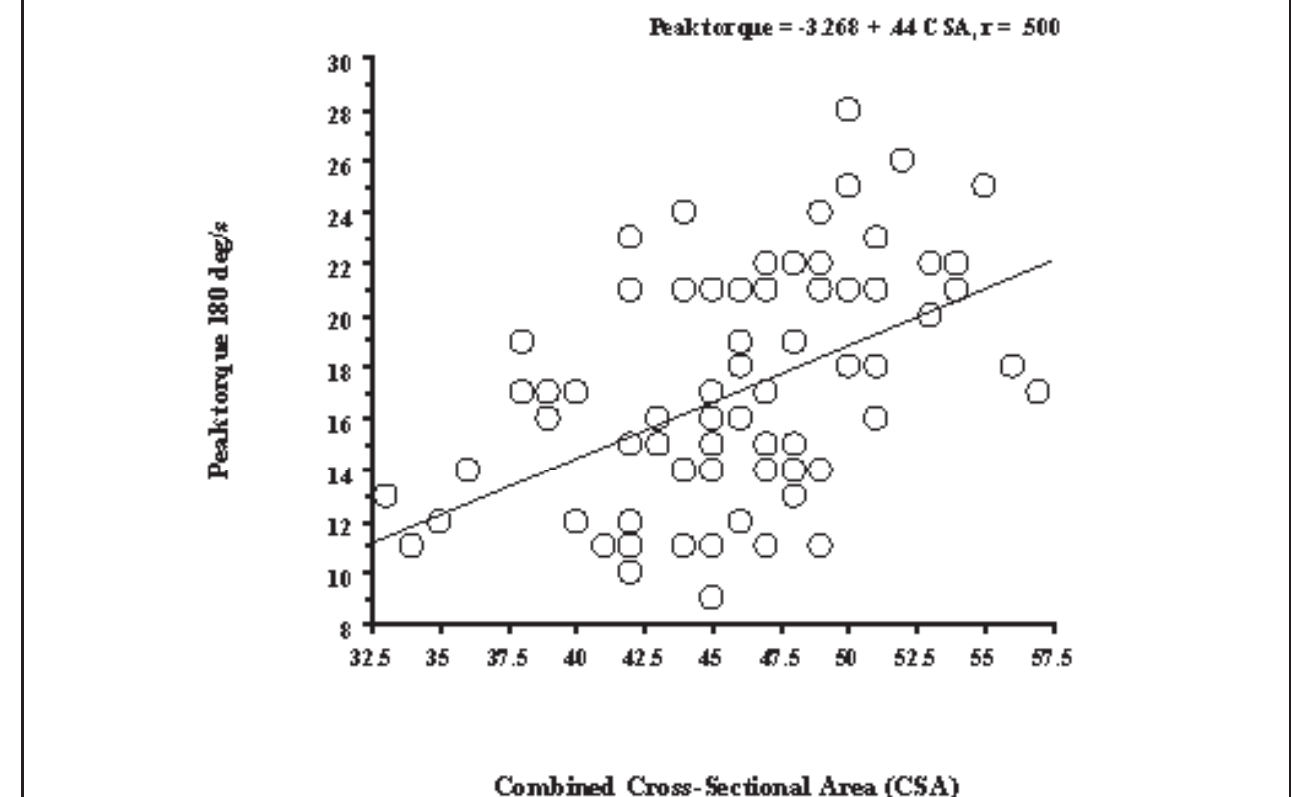
Fig. 4(B): Correlation between CSA and peak torque at 180 deg/s was less strong (B: 180 deg/s angular velocity, r = 0.500, p